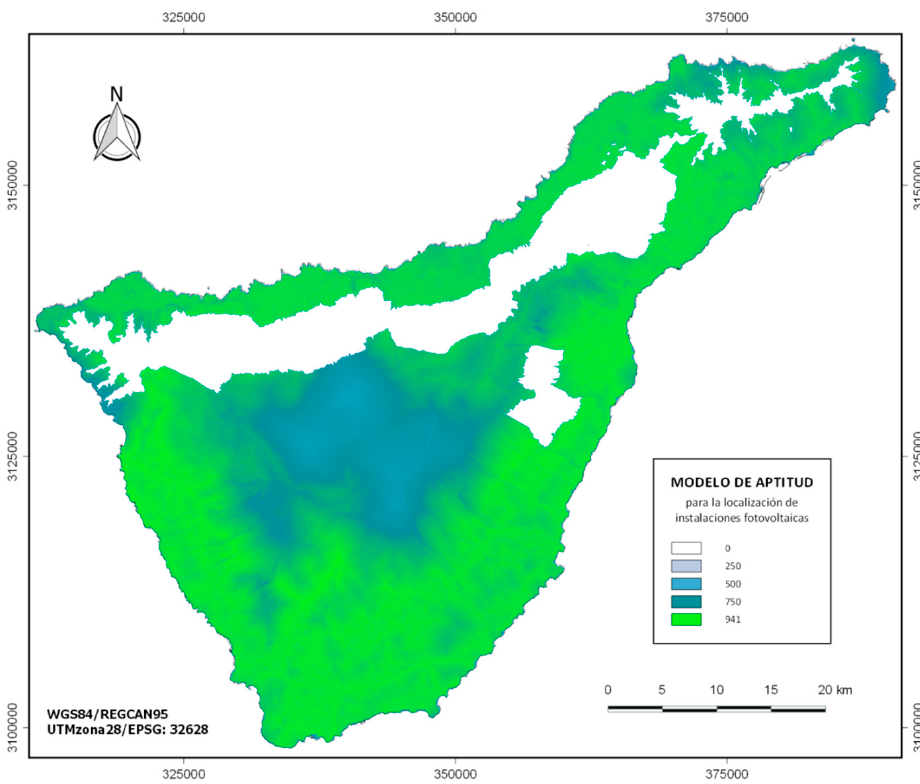
Figure 2. Aptitude Model.